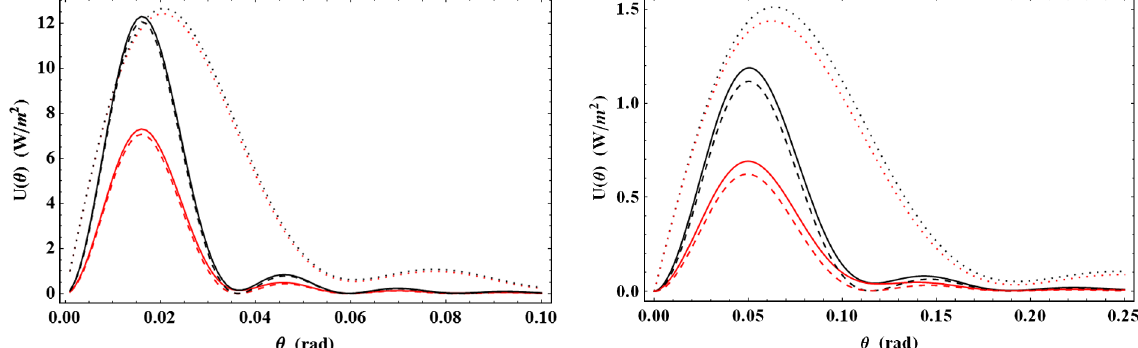
6. The angular distribution of the radiation energy ð q ¼ 0 . 1 nC ; R ¼ 1 m Þ ; a ¼ 1 cm (left), a ¼ 1 mm (right); total density distribution (solid line); second pulse contribution (dashed line); first pulse contribution (dotted line); ς ¼ 1 (black line); ς ¼ 3 (red line). The scale of the distribution curve for the first pulse is increased by 50 times for a ¼ 1 cm (left) and by 20 times for a ¼ 1 mm (right).